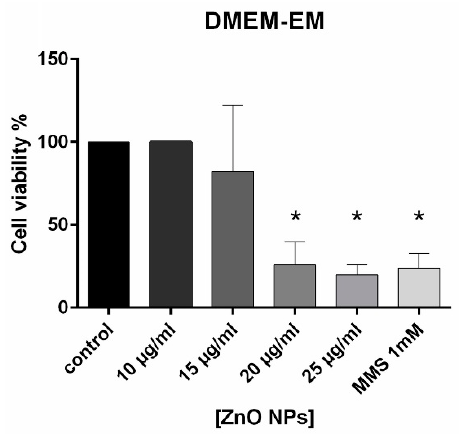
Figure 5. Cytotoxicity. In the MTT assay, the cytotoxic effects of ZnO-NPs in hMSCs cultured in DMEM-EM were analyzed. Statistical analysis was performed as described above. The test showed a significant reduction of hMSC viability at a ZnO-NP concentration of 20 µ g / mL. * indicates the statically significant changes.